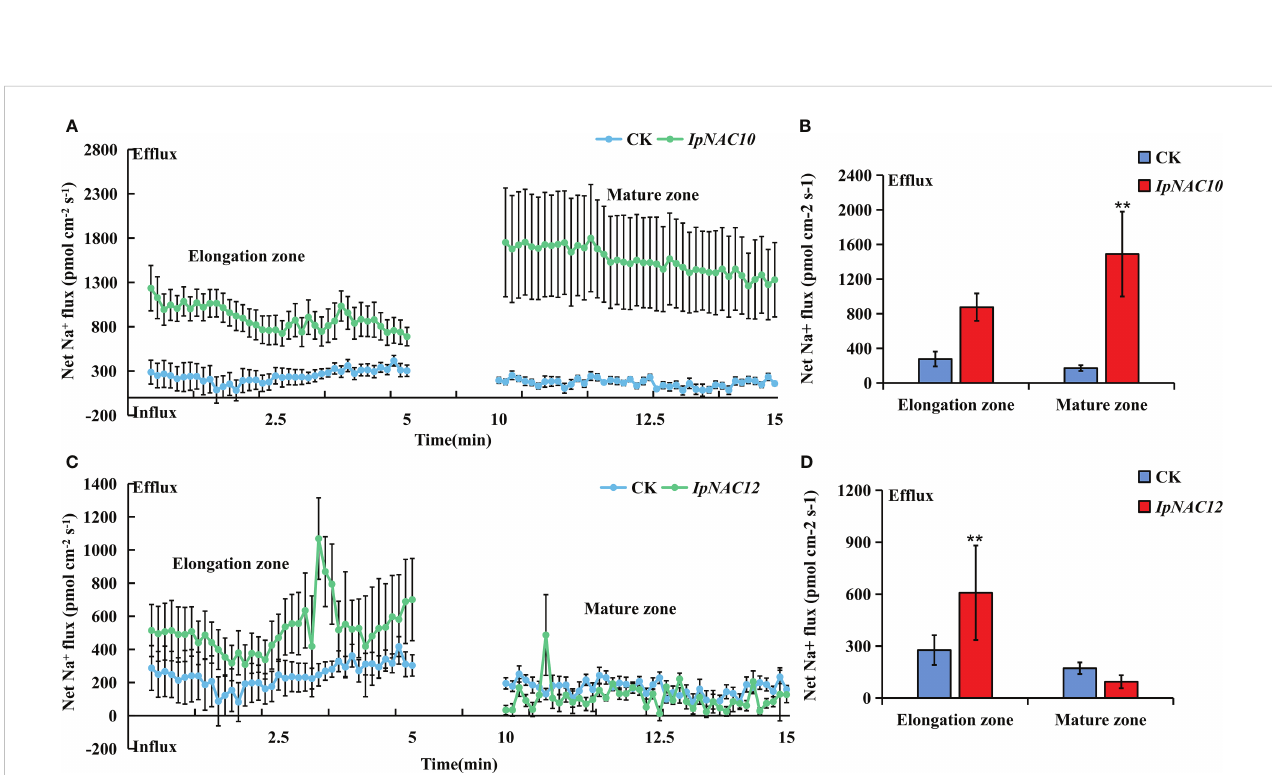
FIGURE 11 Na + fl ux determination in IpNAC10/12 -overexpressing sweetpotato roots. (A, C) The steady-state Na + fl uxes in the AR and TR, including the elongation and mature zones, after 24 h of NaCl treatment (150 mM). The standard errors of the means are represented by the bars. (B, D) Mean net Na + ef fl ux rates in (A, C) , respectively. Asterisks indicate the level of signi fi cance between the AR and TR groups at ** p < 0.01 .